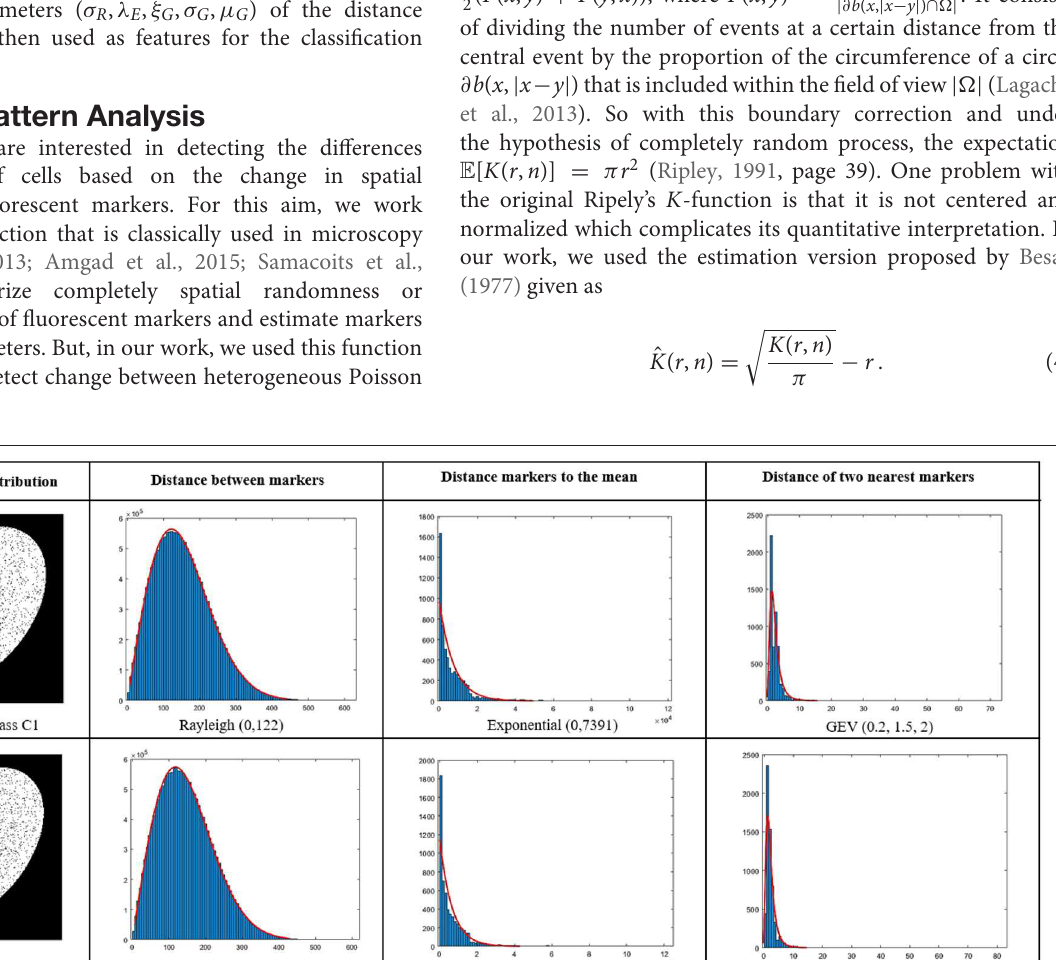
Frontiers in Robotics and AI |